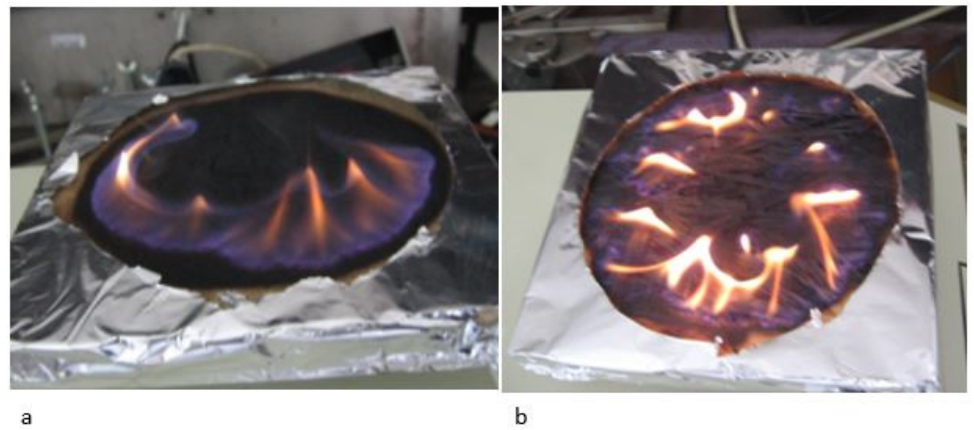
Figure 3. ( a ) Burning process of particleboard samples with 15 mm thickness after their ignition by radiant heat at 48 kW.m − 2 in 80 s; ( b ) OSB sample with 15 mm thickness during experiment in 80 s at 48 kW.m − 2 .